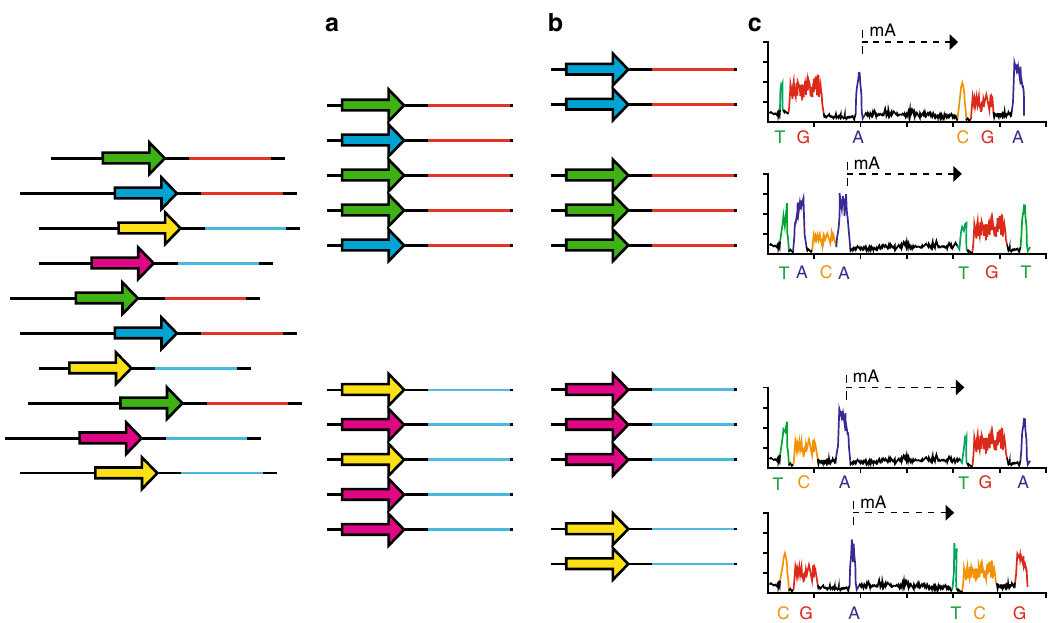
Fig. 2 Handling of the sequences. a mapping based selection of the sequences based upon the motif cassette; b 2nd round of mapping based selection based upon both the motif cassette and the gene coding for the methyltransferases; c analysing the grouped sequences though the ‘ Modi fi cation and Motif_Analysis ’